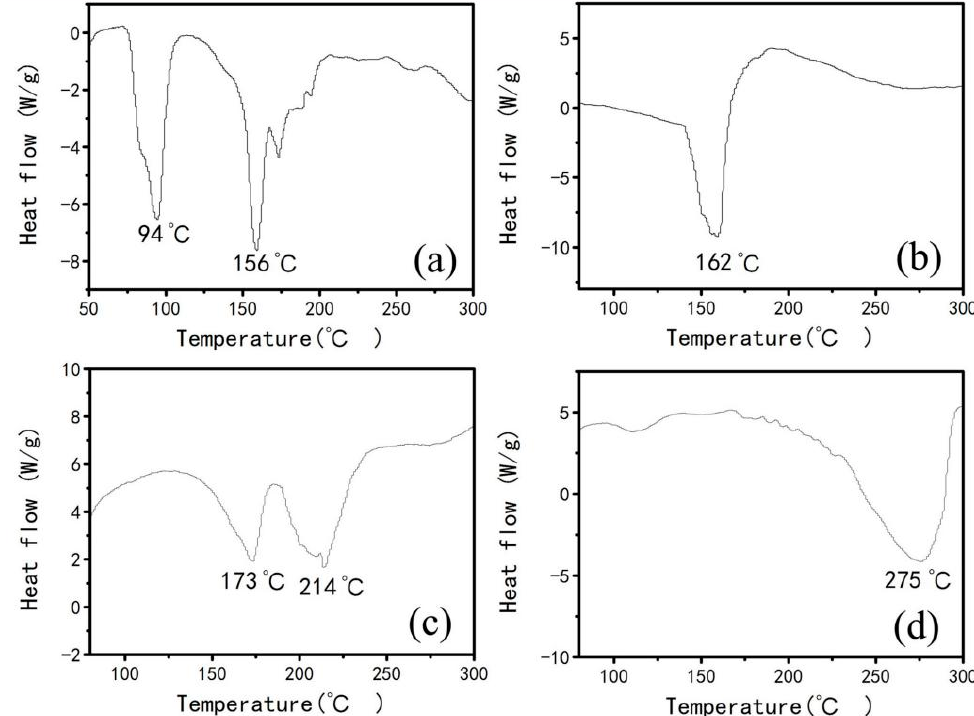
Figure 7. DTA curves of various substances: ( a ) glucose; ( b ) complex formed between glucose and aluminum nitrate (C/Al = 8); ( c ) complex formed among glucose, urea, and aluminum nitrate (C/Al = 8, U/Al = 1); ( d ) complex formed between urea and aluminum nitrate (U/Al = 1).